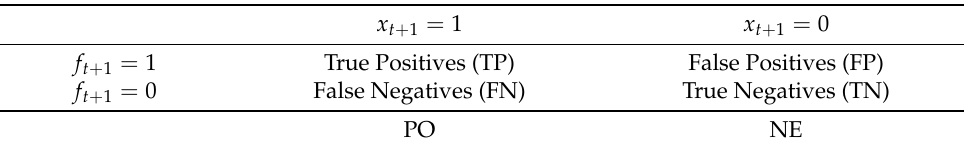
Table 2. Contingency